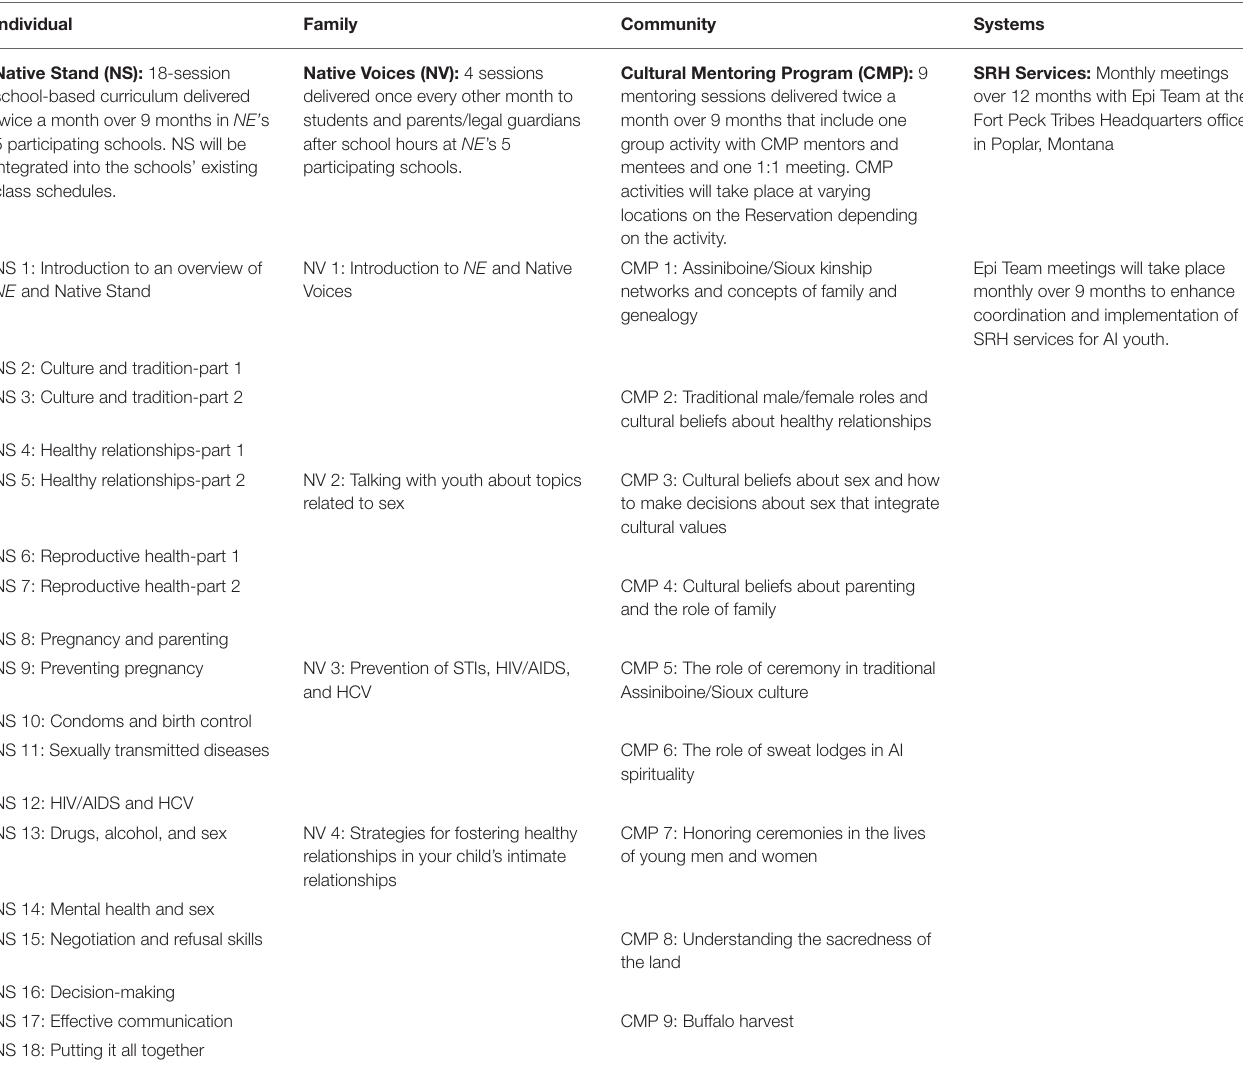
TABLE 1 | Overview of NE ’s 9-month multi-level, multi-component intervention plan. Individual Family Community